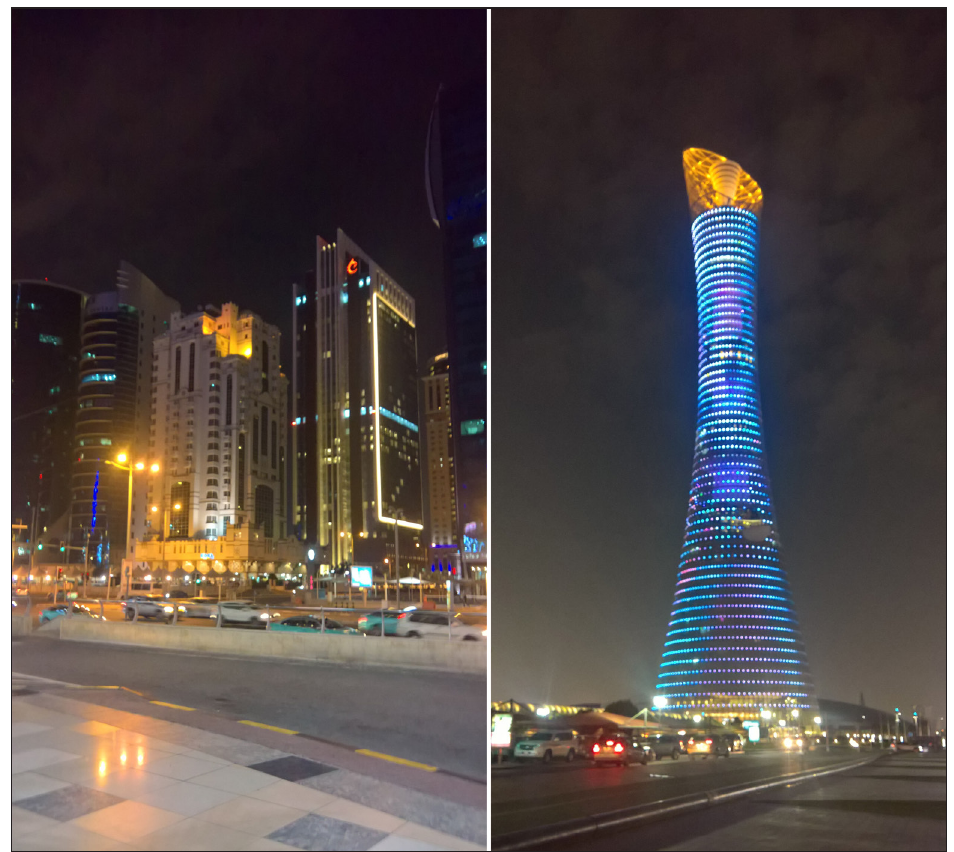
Figure 5: Doha city centre and the